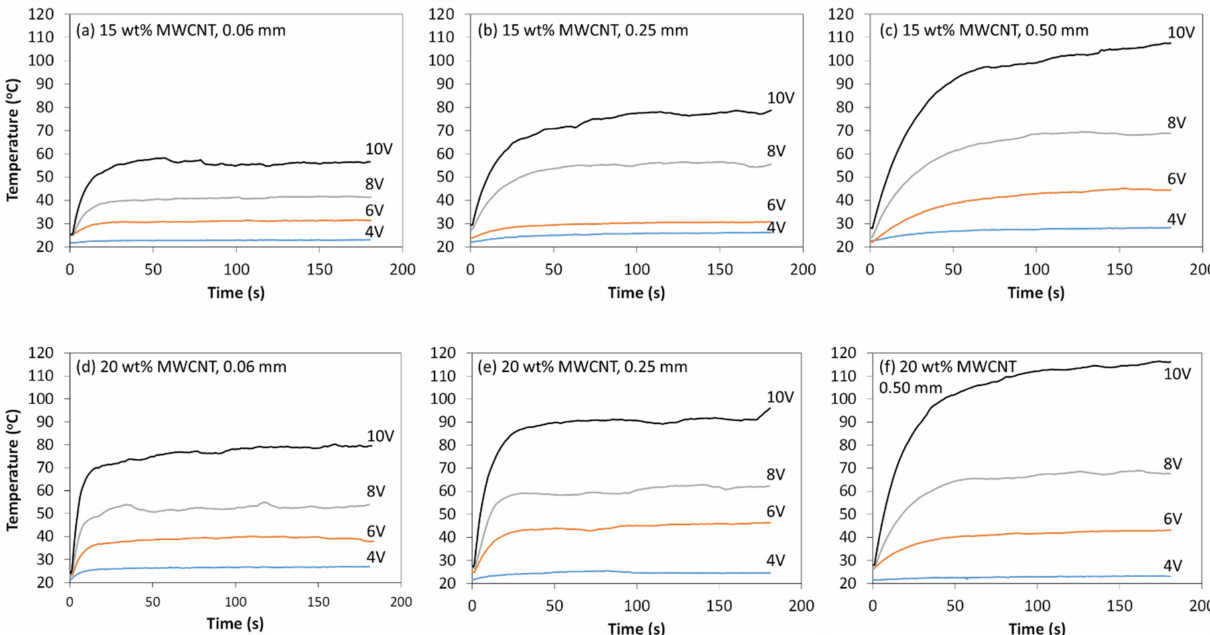
Figure 7. Temperature profiles of MWCNT/PP nanocomposite films at different input voltages and thicknesses: ( a – c ) 15 wt.% MWCNT, 0.06 mm, 0.25 mm and 0.50 mm thicknesses, respectively; and ( d – f ) 20 wt.% MWCNT, 0.06 mm, 0.25 mm and 0.50 mm thicknesses, respectively.